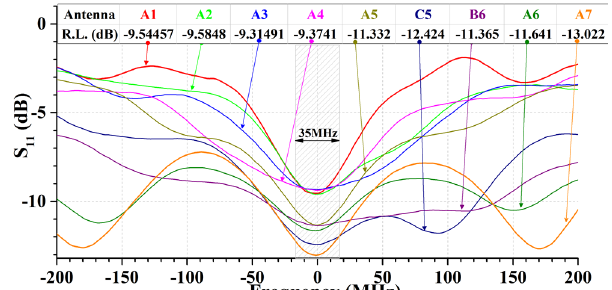
Figure. 3. The variation of S 11 of various antennas in 400MHz span around their resonant frequency. The hashed are in center of plot is the equal fractional bandwidth of A 1 in respect to 400MHz for A 7